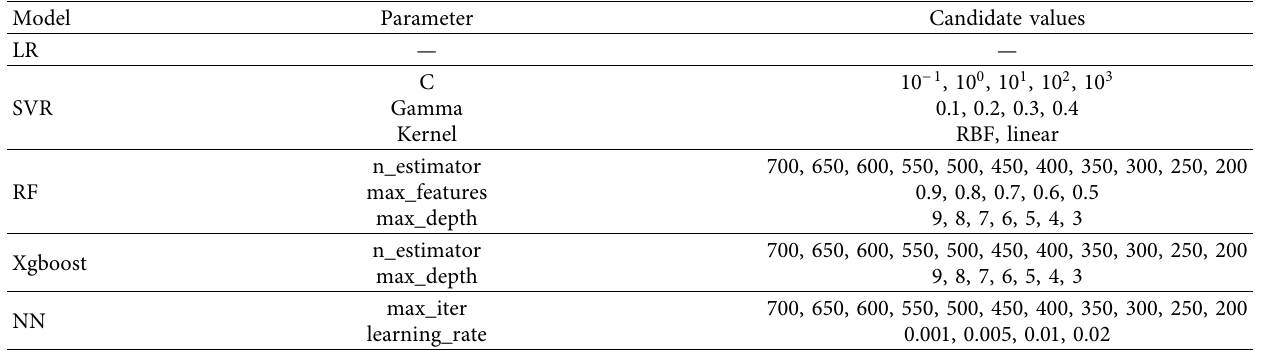
Table 2: Hyperparameter grid.